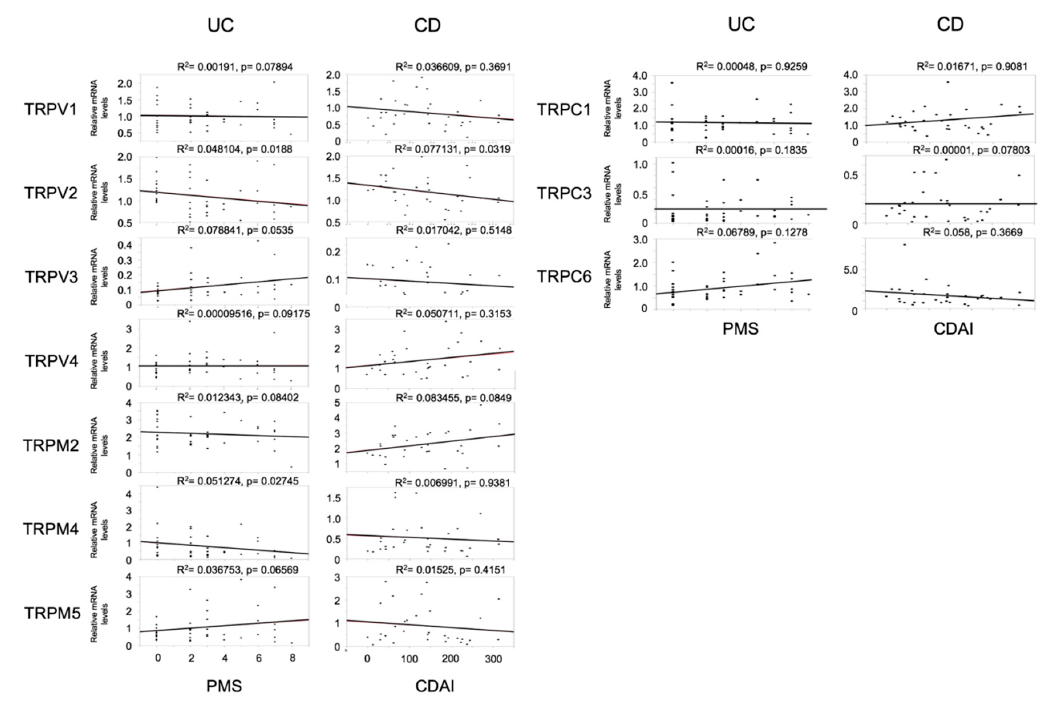
Figure 2. Correlation between TRP channel expression and clinical disease progression in patients with ulcerative colitis (UC) and Crohn’s disease (CD). Clinical disease progression was assessed using the partial Mayo score (PMS) for patients with UC and the CD activity index (CDAI) for patients with CD. N: Number of patients.